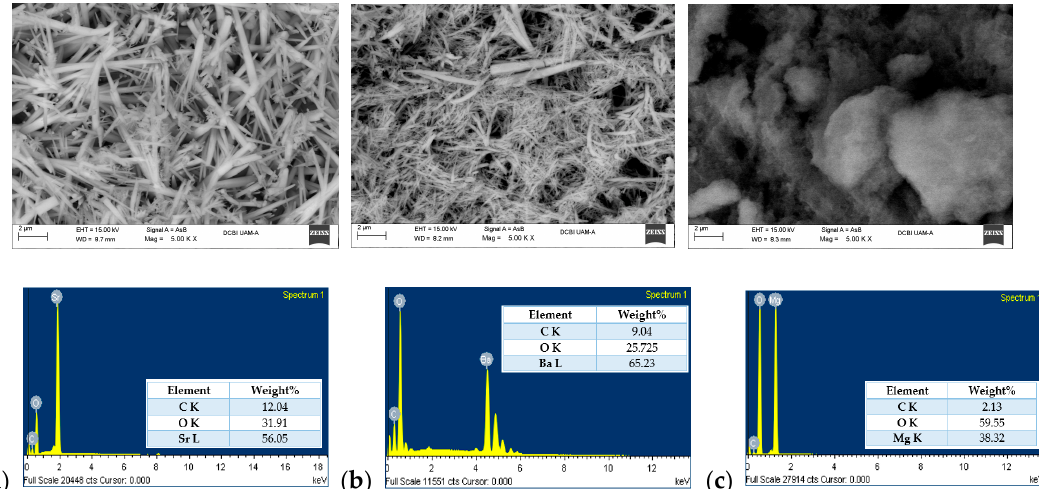
Figure 3 . Micrographs and EDS analysis of the solids recovered after the carbonation reactions with ( a ) Sr(OH) 2 ; ( b ) Ba(OH) 2 ; ( c ) Mg(NO 3 ) 2